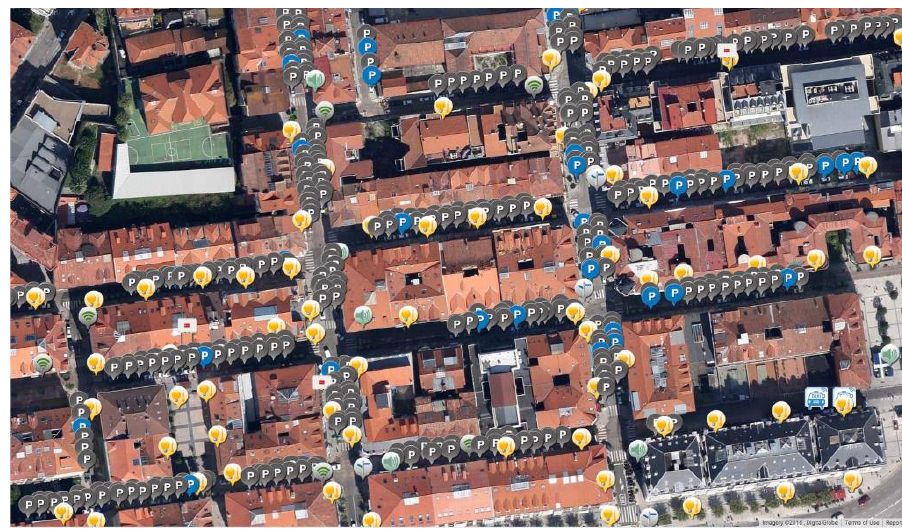
Figure 3. Detailed view of outdoor parking sensors deployment.